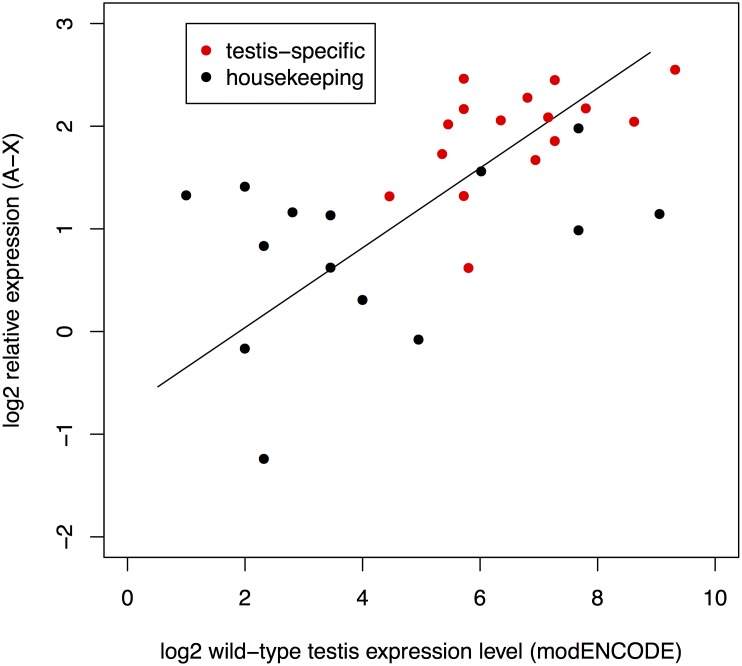
X-linked genes with higher expression levels in wild-type testes show a greater magnitude of escape from X suppression when relocated to an autosome.Standard major axis regression of magnitude of X suppression and expression level determined from RNAseq analysis of dissected testes reveals a significant relationship (r2 = 0.36, p = 0.0005). It is unclear whether the nature or magnitude of this relationship differs between testis-specific and housekeeping genes; this regression is non-significant within housekeeping genes (p = 0.22) and marginally significant within testis-specific genes (r2 = 0.26, p = 0.05), but there is no significant difference in the regression slope estimate between these two groups (p = 0.66, by likelihood ratio test using the smatr package in R). Data found in S1 Data.